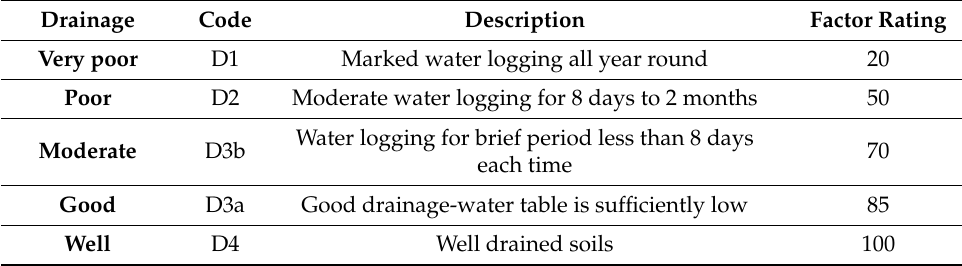
Table 6. Factor ratings of drainage.